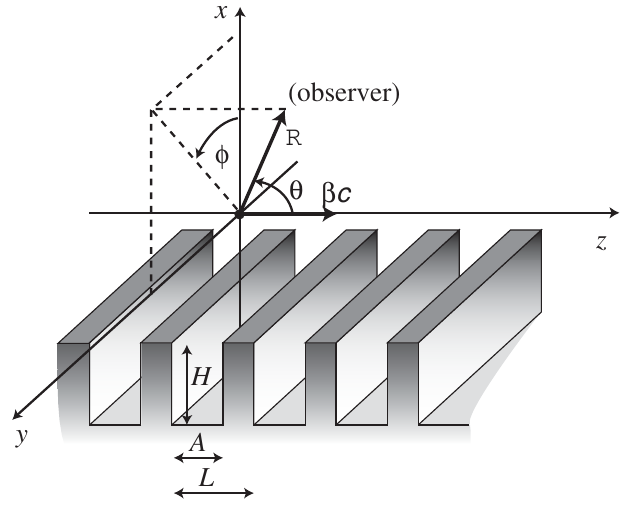
FIG. 1. Smith-Purcell